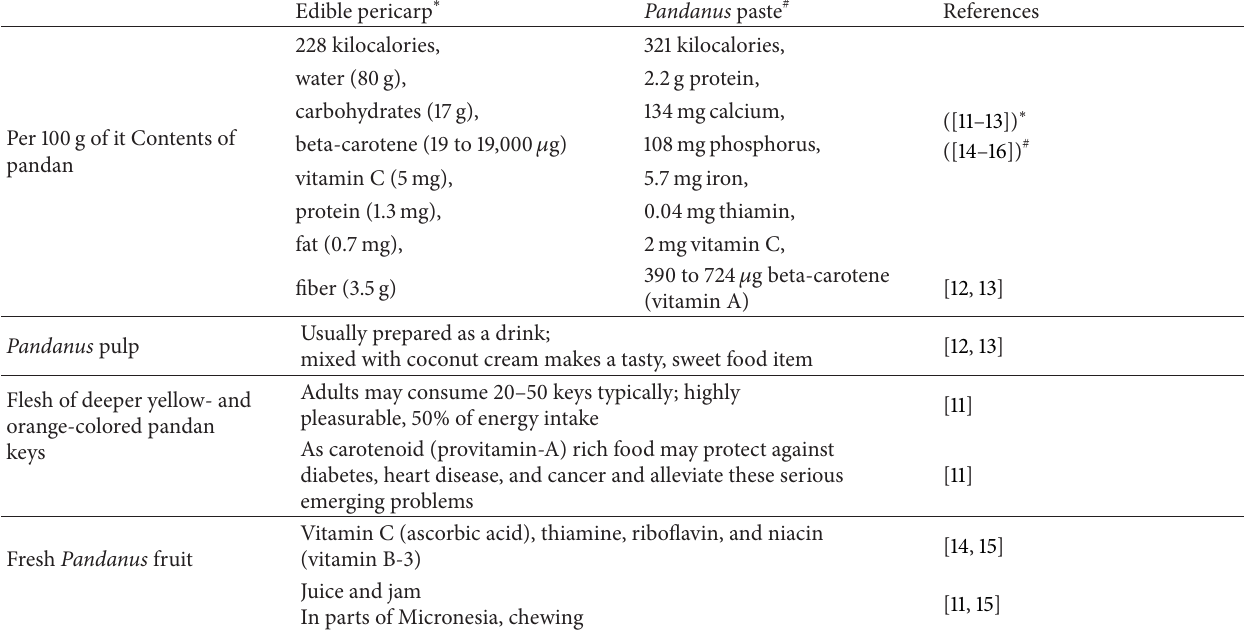
Table 5: Nutritional aspects of Pandanus or screw